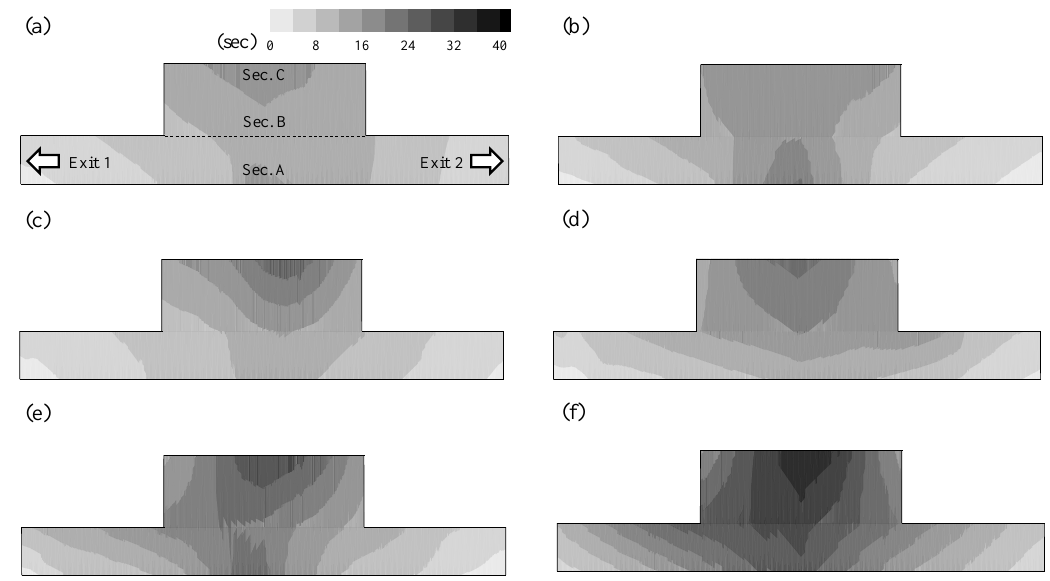
Figure 12. Spatial distributions of the underground evacuation time: ( a ) Case P1Q1; ( b ) Case P12Q1; ( c ) Case P13Q1; ( d ) Case P14Q1; ( e ) Case P123Q1; ( f ) Case P1234Q1.